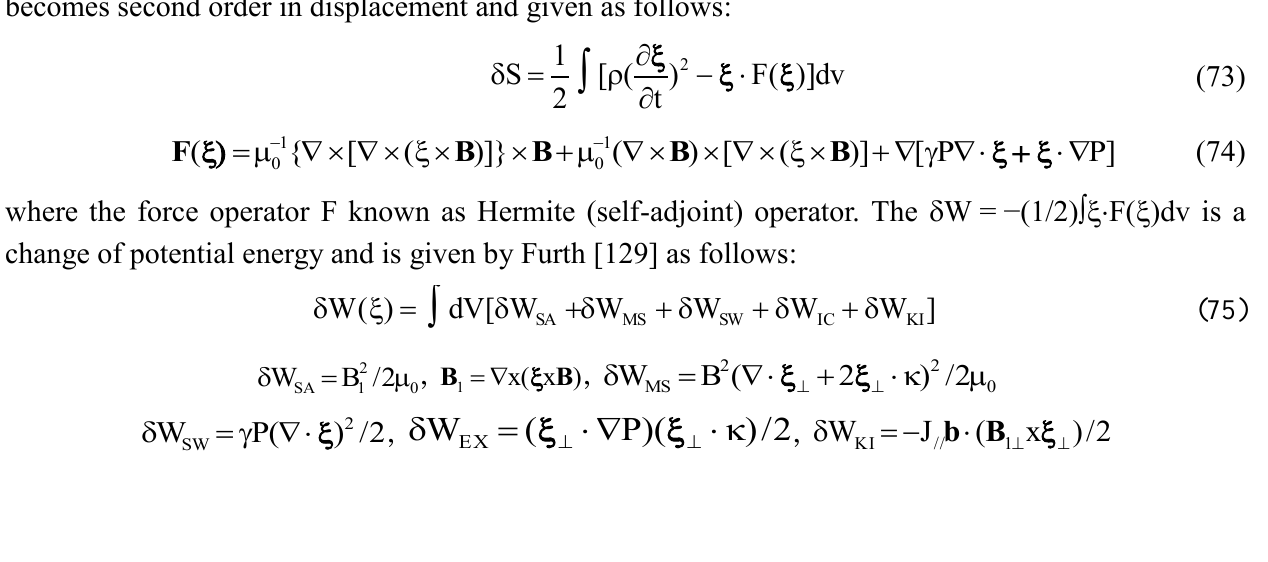
Figure 24. Comparison of calculated and measured beam driven current (left) and NBCD current drive efficiency as a function of central electron temperature T